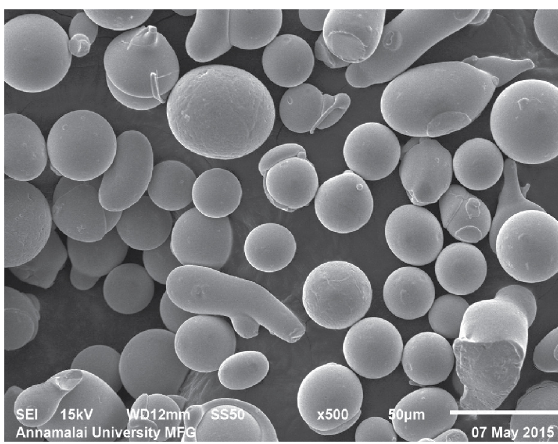
Figure 1: SEM of an Fe-based amorphous metallic